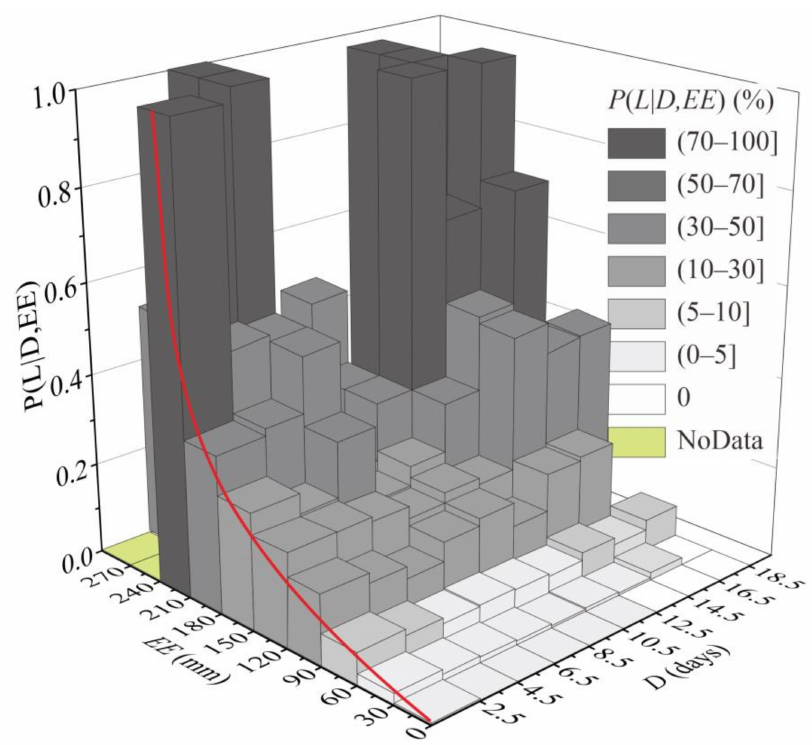
Figure 10. Histogram of the posterior probability of landslide occurrence given the conditions of D and